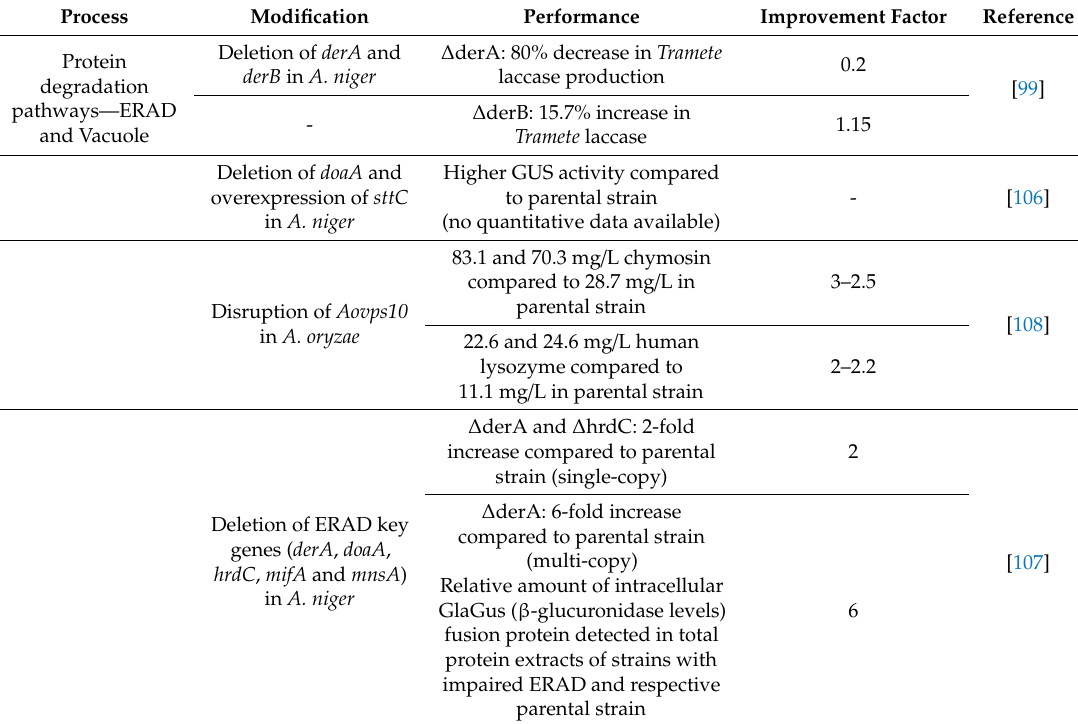
Table 8. Approaches for improving recombinant protein production through engineering protein degradation